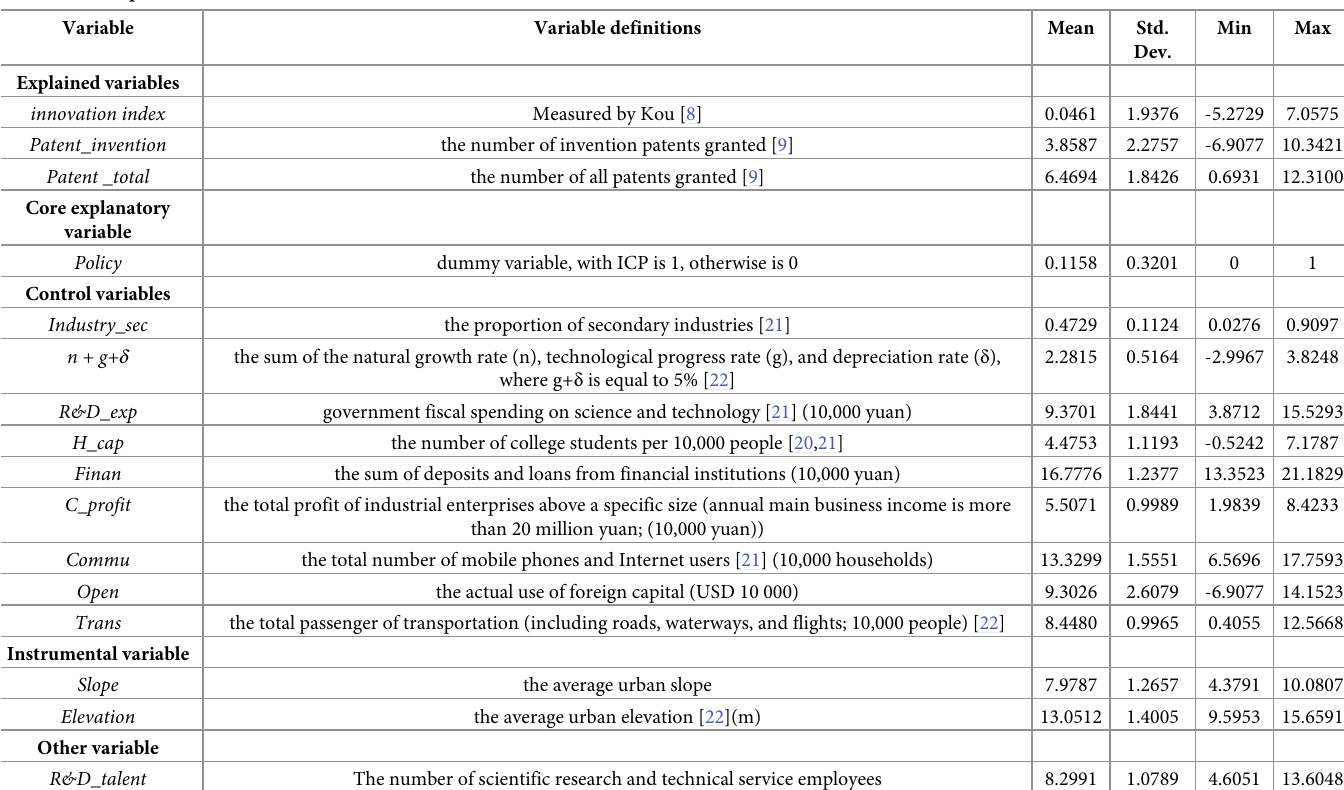
Table 2. Descriptive statistics.